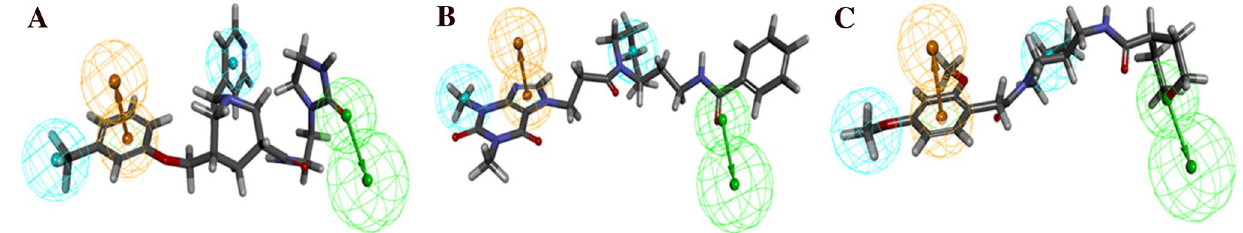
Figure 7. Final hit compounds mapped to the best pharmacophore model, Hypo 1; ( A ) Hit 1, ( B ) Hit 2 and ( C ) Hit 3. The HBA, RA, and HYP features are displayed in green, orange, and cyan, respectively. Hit compounds are represented as stick models. The figure is drawn using DS v3.5.